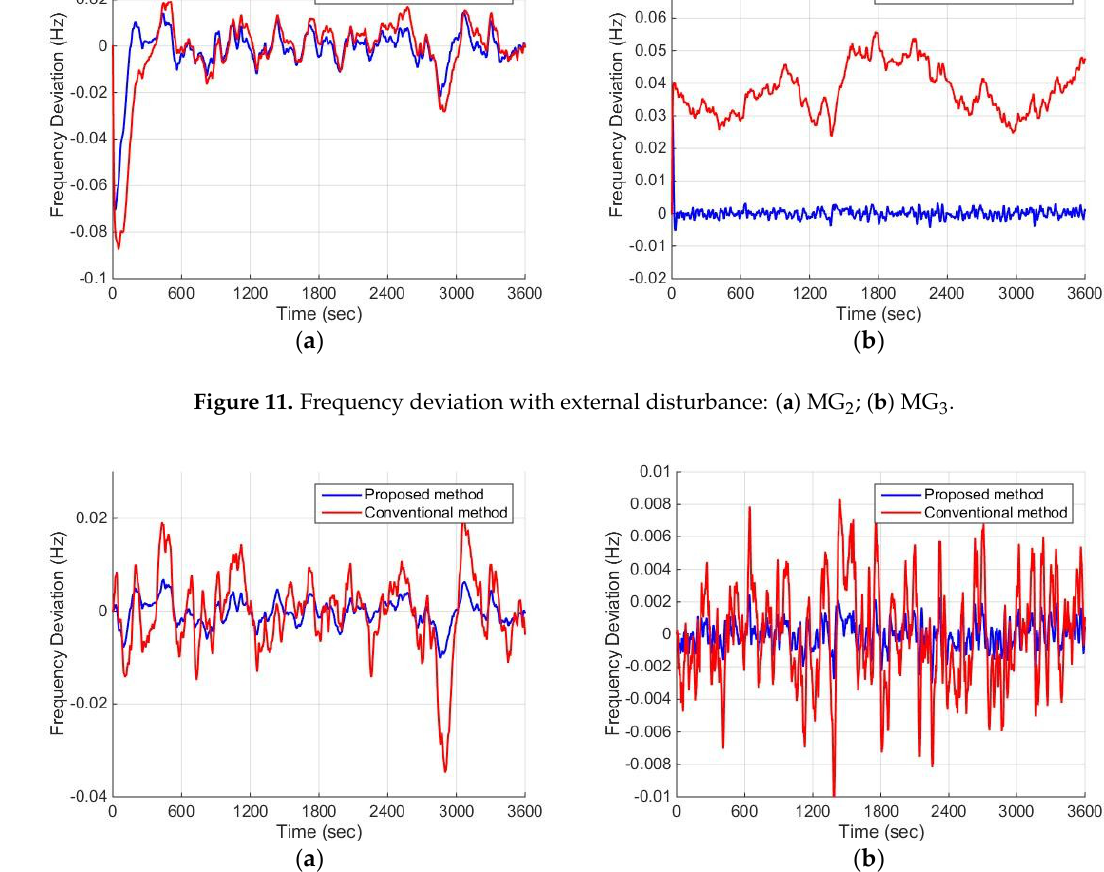
Figure 12. Frequency deviation with system parameter uncertainties: ( a ) MG 2 ; ( b ) MG 3 . Energies 2018 , 11 , x FOR PEER REVIEW